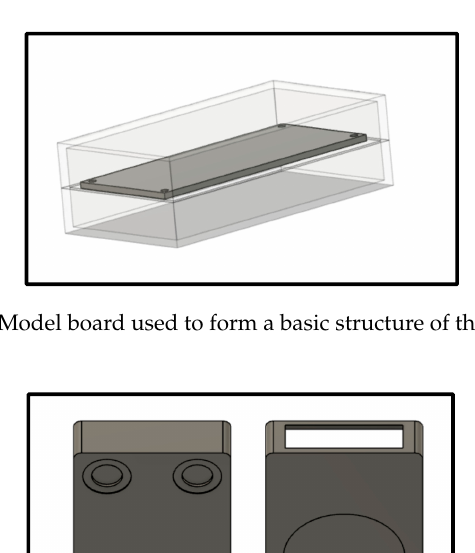
Figure 12. Sock prototype featuring wire coverings and band to form-fit SRS.